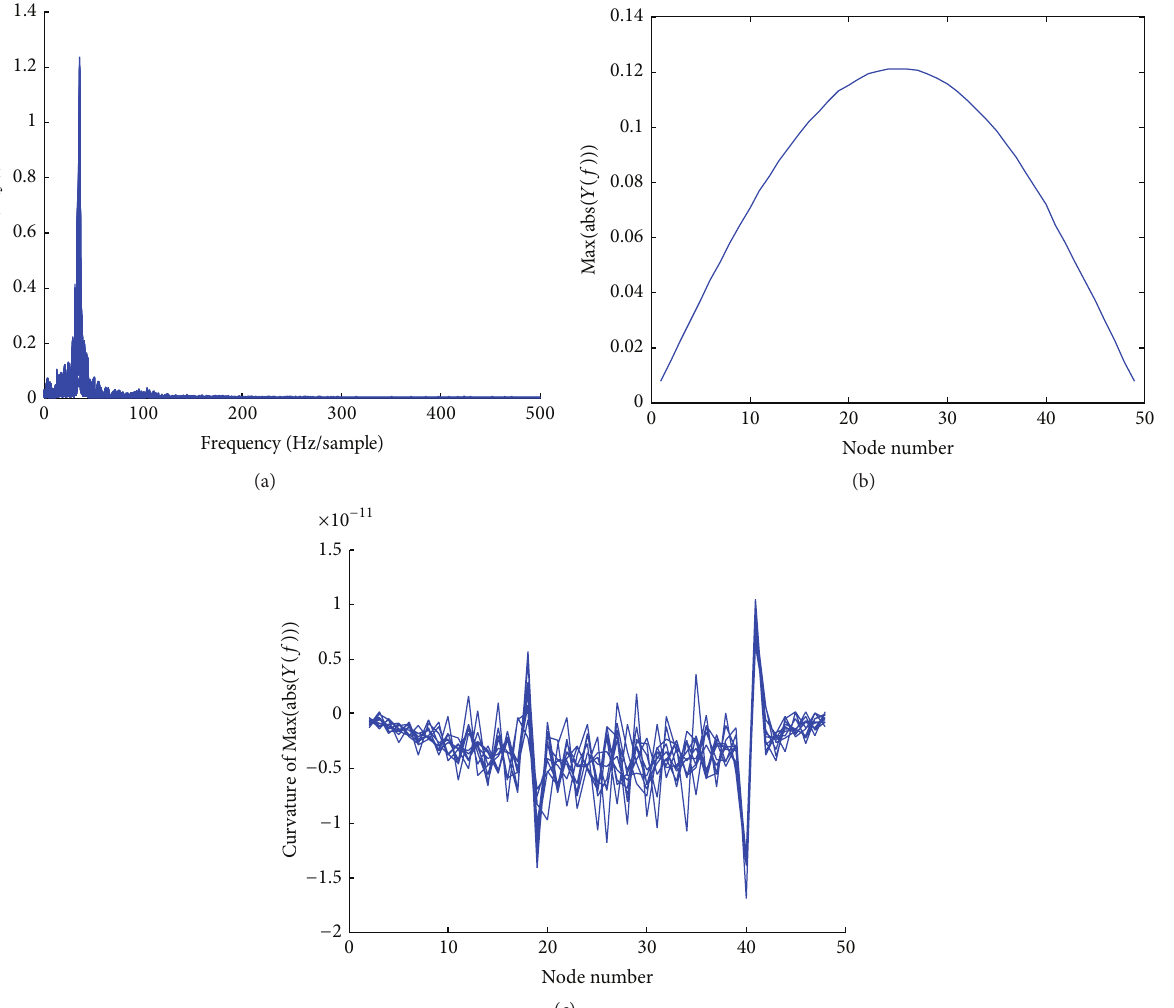
Figure 3: Numerical results in the frequency-domain: (a) FFT curves, (b) maximum FFT curve corresponding to the first resonance frequency, and (c) its curvature curves.